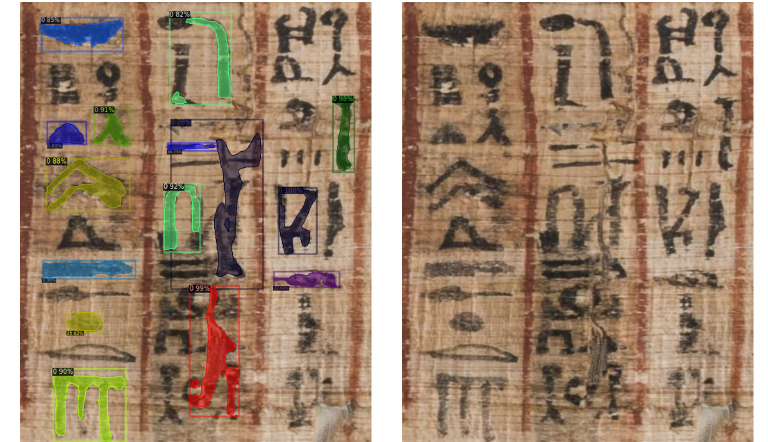
Figure 10. Example of critical segmentation results (on Cyperus papyrus, from the Egyptian Museum of Turin online collection, Book of the Dead of Nebhepet, scribe of the necropolis , cat. number 1768): on the left the original document, on the right the segmented